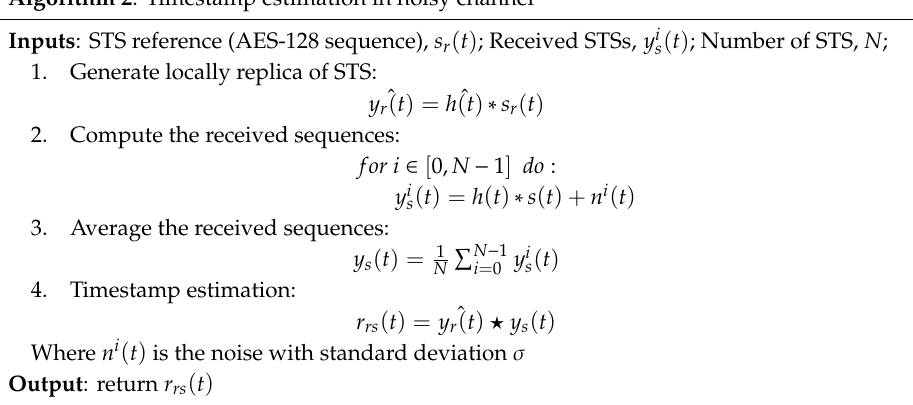
Algorithm 2 : Timestamp estimation in noisy